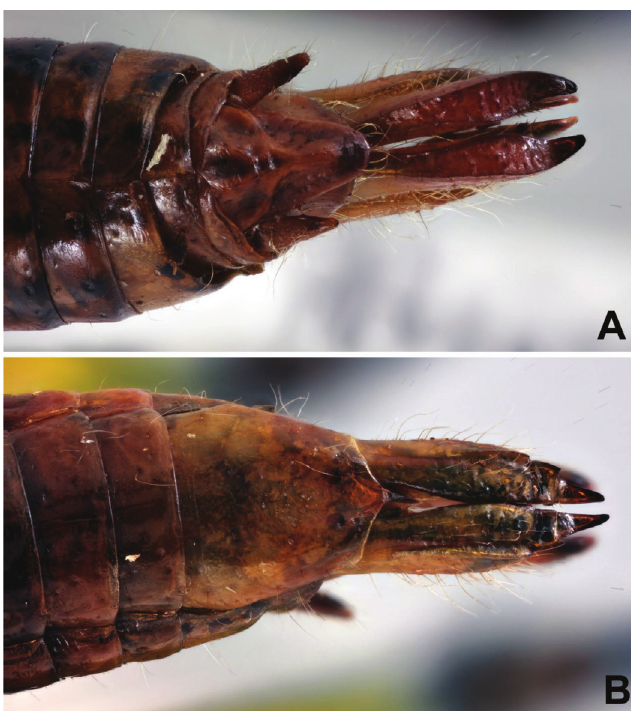
Fig. 6. Abdominal apex of female Physocrobylus venetus sp. nov. A. Dorsal view; and B. Ventral view.